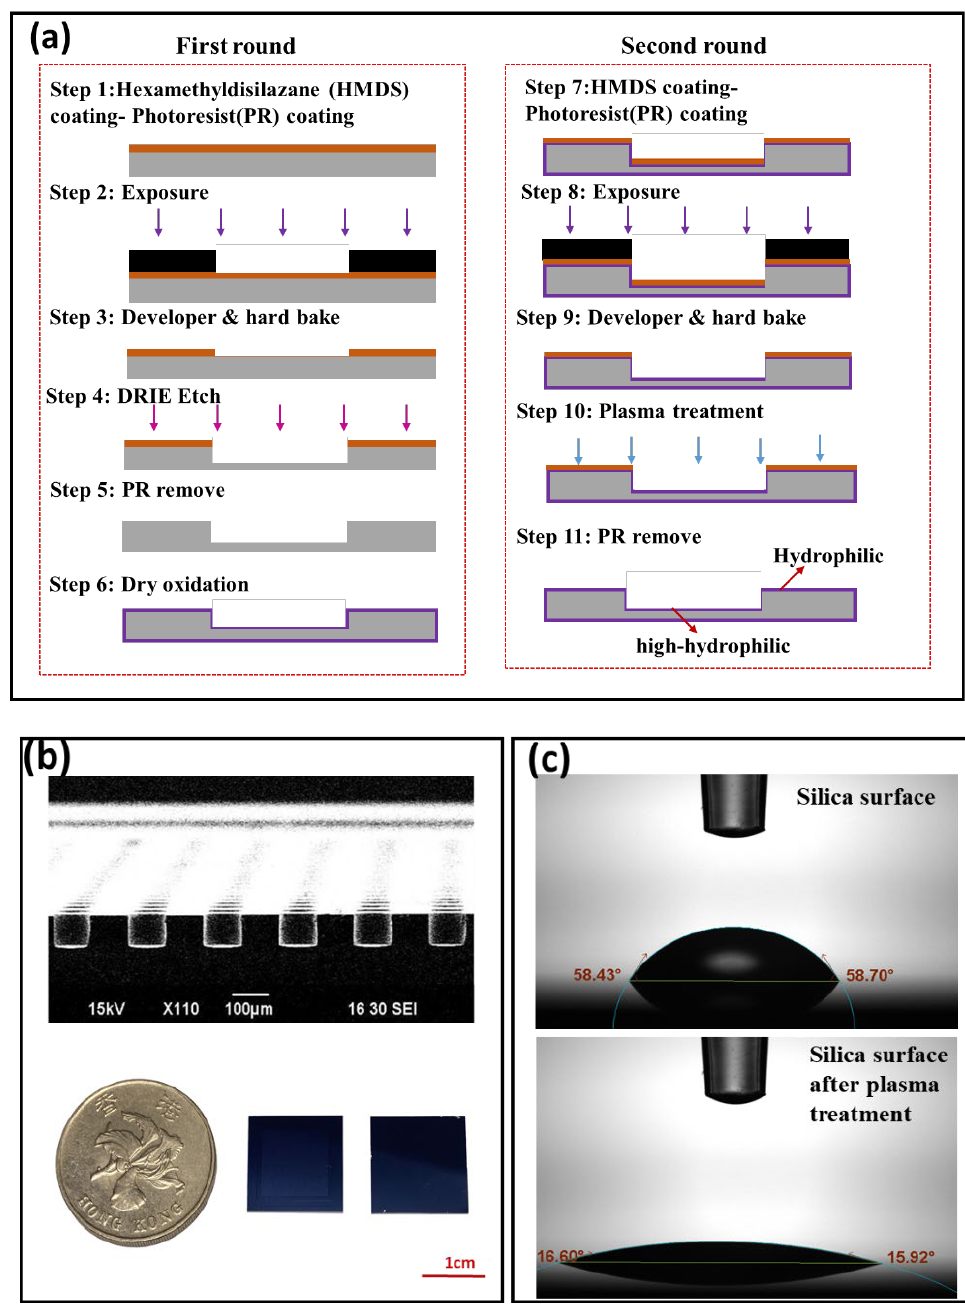
Figure 1. ( a ) The fabrication process of the SDA dPCR chip. ( b ) The upper part of the figure is the SEM image of the etched cross-section of the chip, and the lower part of the figure is the image of the dPCR chip. ( c ) Contact angle on silica surface and after plasma treatment.